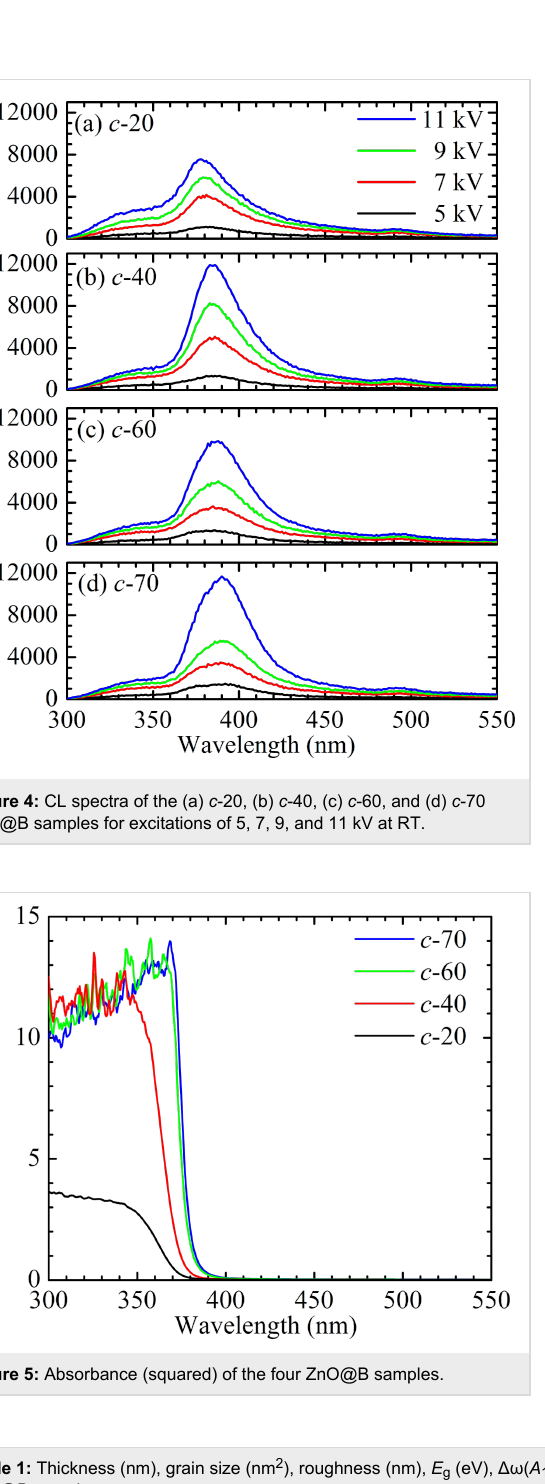
Table 1: Thickness (nm), grain size (nm 2 ), roughness (nm), E g (eV), Δω ( A 1 (TO)) (cm − 1 ), ε (%), and sheet resistance ( R sheet ) (ohm/ □ ) for the four ZnO@B samples. Sample